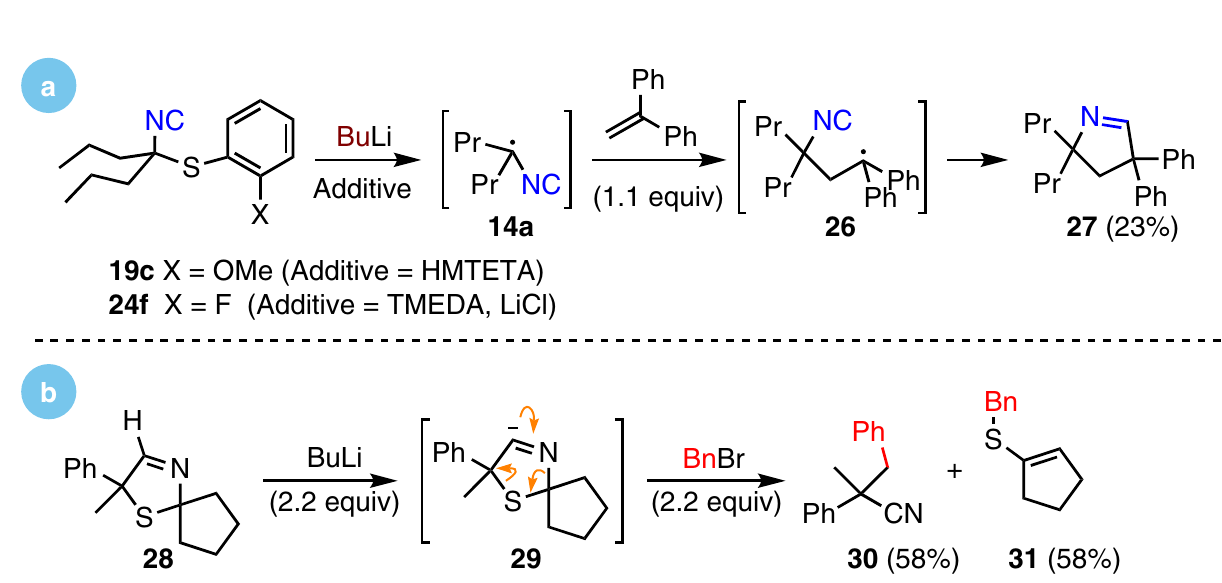
Fig. 7 | DialkylAsmic dearomatization mechanism. a Trapping with diphenylethylene is consistent with the formation of radical intermediates. b The formal [3+2] cycloreversion of 28 is consistent with the computationally determined dislocation